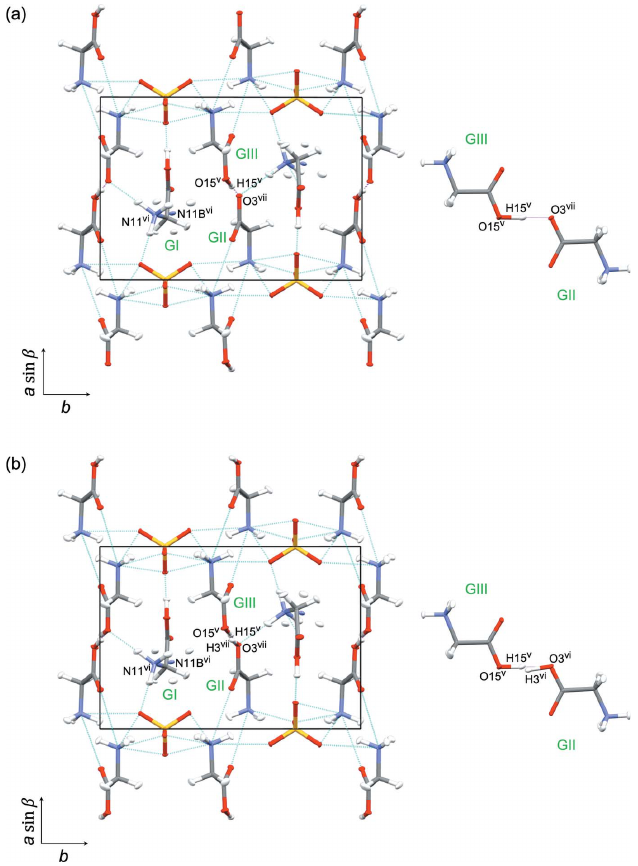
Figure 5 [001] projection of the unit cell and detail of the hydrogen bond between GII and GIII of HTGS at 298 K with hydrogen bonds shown as dashed lines. The short O15—H15 (cid:2)(cid:2)(cid:2) O3 bonds are shown as pink dashed lines. Atoms N11 and N11 B are disordered with occupancies of 87.5%/12.5%. Model 1 ( a ); a single-minimum potential energy model for H5; model 2 ( b ); a double-minimum potential-energy model for H15 and H3. Symmetry codes: (v) 1 (cid:3) x , (cid:3) 1 + y , 1 (cid:3) z ; (vi) 1 (cid:3) x , (cid:3) 1 + y , 2 (cid:3) z ; 2 2 (vii) x , (cid:3) 1 + y , 1 + z .